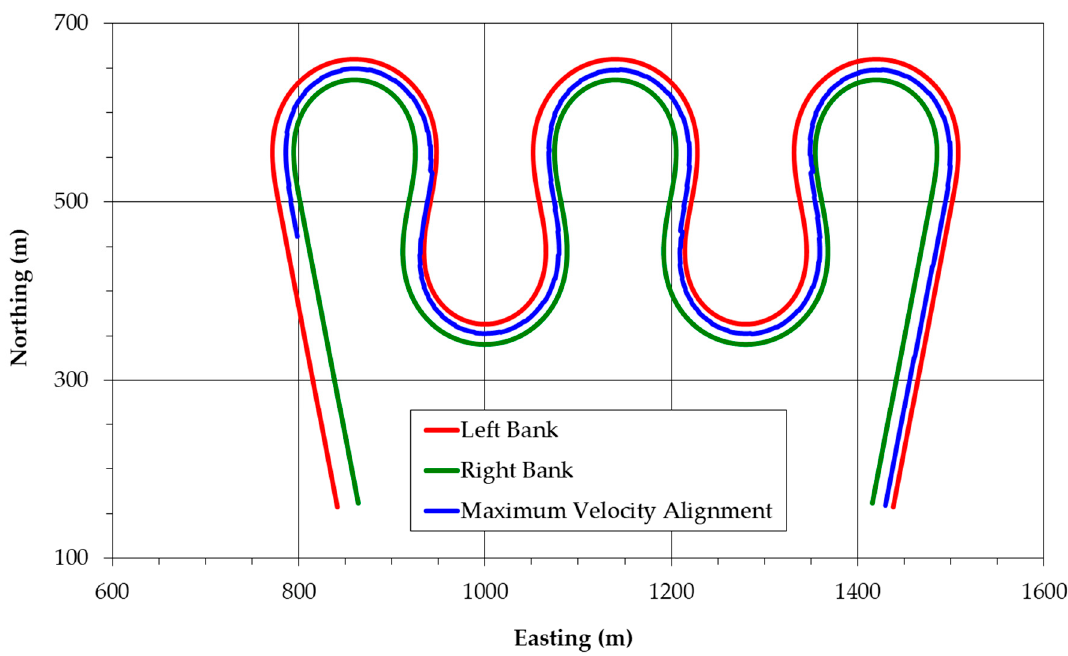
Figure 29. Simulated thread of maximum velocity for Simulation Set 5 with a sinuosity of 2.75.